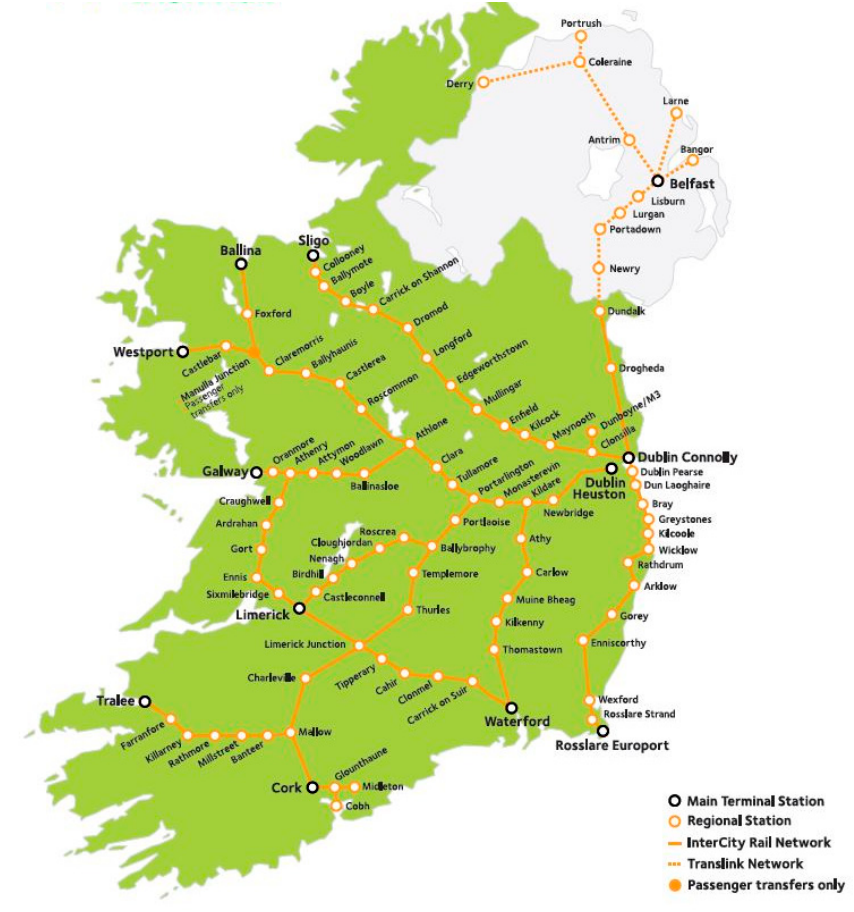
Figure 5. Irish Rail network